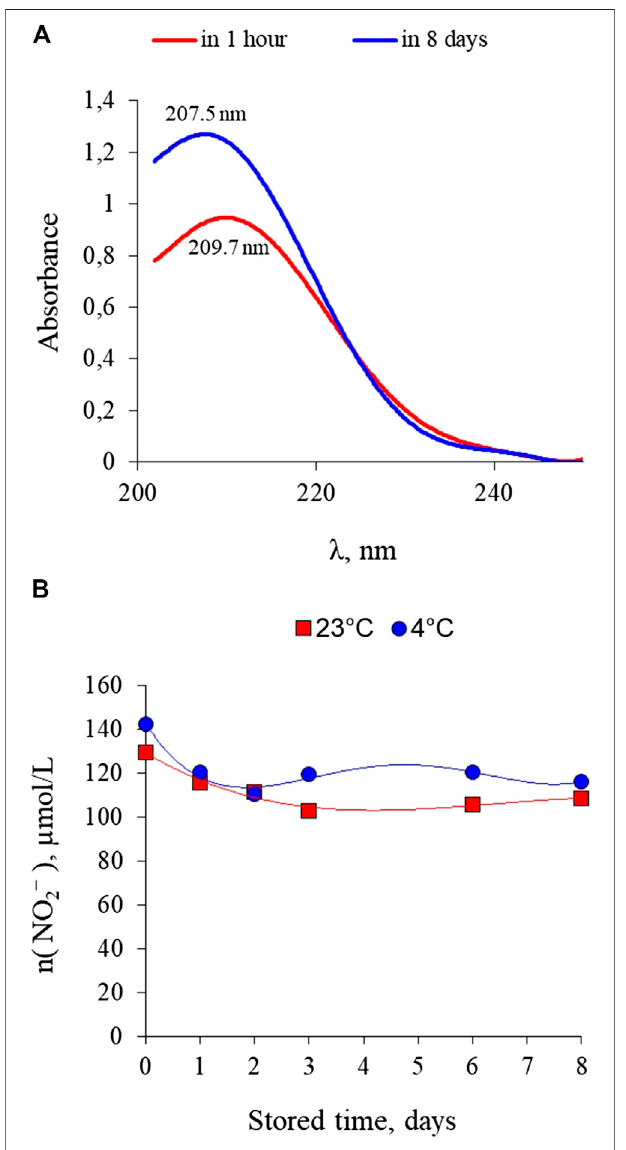
FIGURE 8 | (A) Change with time of the absorbance curve of distilled wateraftertreatment.Processingwascarriedoutfor3 mininthewelloftheplate with a liquid volume of 5 ml. (B) The change in the concentration of nitrite ion (NO2 – ) in distilled water after treatment. Processing was carried out for 3 min in the well of the plate with a liquid volume of 5 ml, T 1 (cid:2) 23 ° C, T 2 (cid:2) 4 ° C.